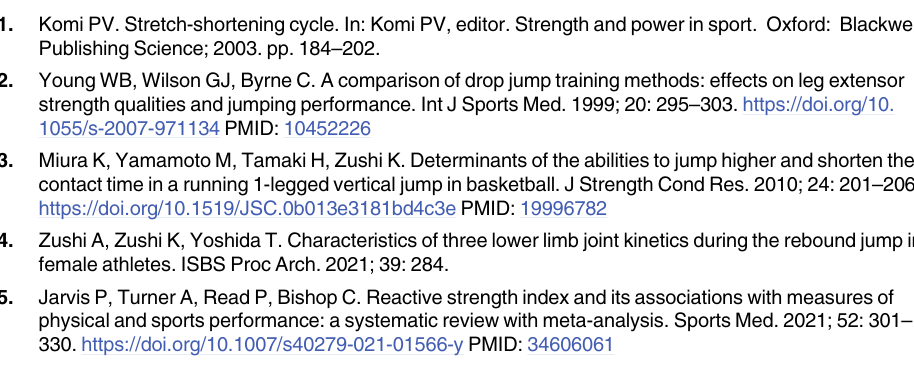
S1 Table. Individual data of RJ performance and kinetics variables at the three lower lower